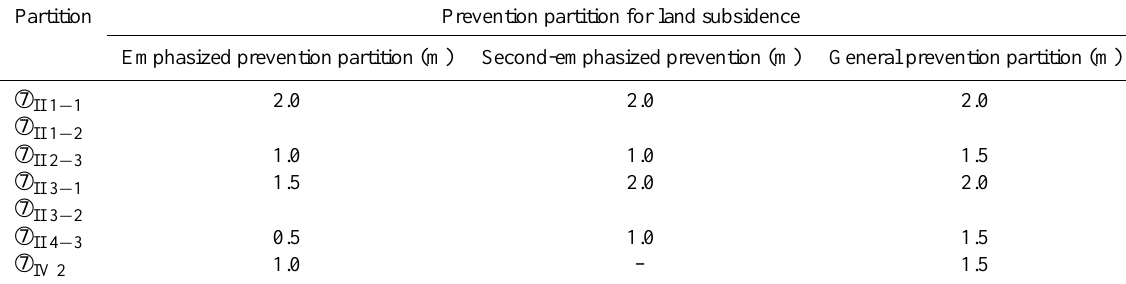
Table 4. Control indexes of drawdown for partitions for land subsidence induced by engineering